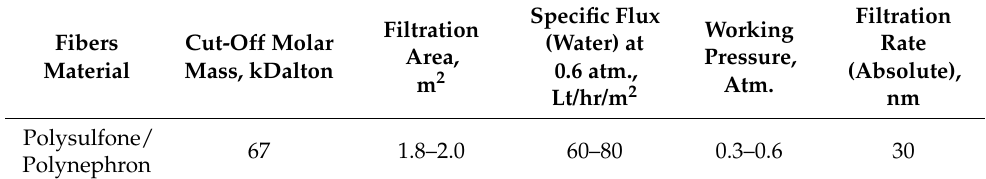
Specific Flux Filtration (Water) at Area, 0.6 atm., m 2 Lt/hr/m 2